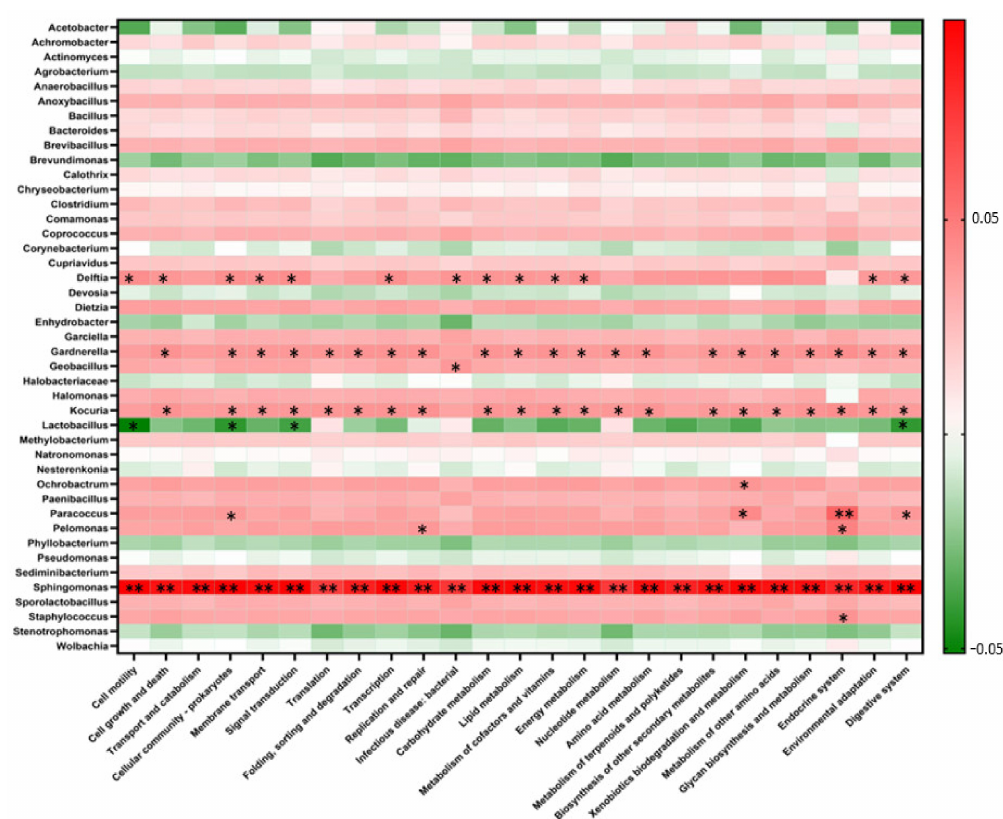
Figure 6. Correlation between the bacterial fermentation community and predicted functional profiles based on 16S rRNA amplicon. Pearson correlation analysis heatmap constructed for each pairwise comparison between level 2 Kyoto Encyclopedia of Genes and Genomes (KEGG) pathways and bacterial taxa at the genus level. The positive and negative correlations are indicated in red and green colors, respectively. The correlation was considered significant at ** p < 0.01 and * p <